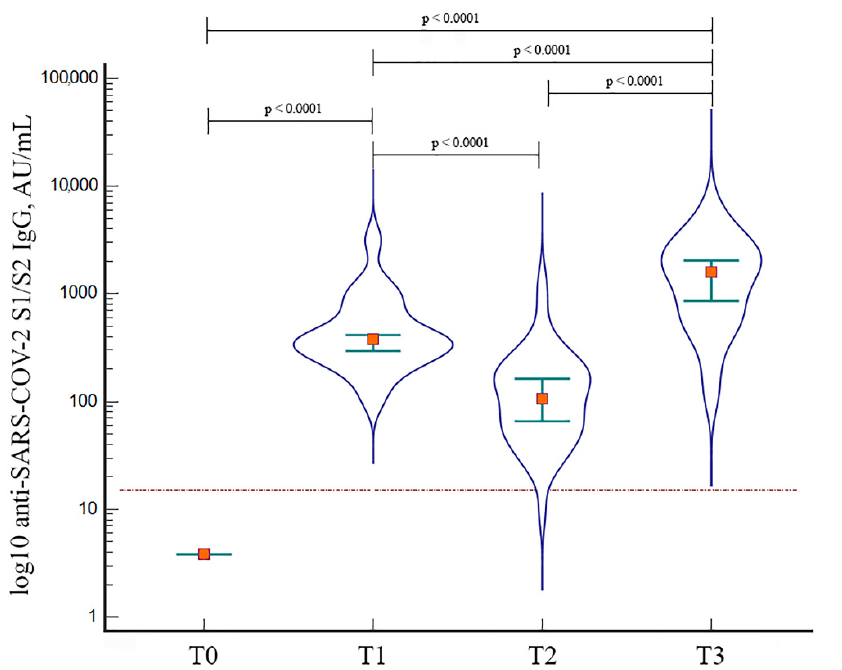
Figure 1. Violin plot showing the median concentration (orange box) of anti-SARS-CoV-2 S1/S2 IgG at the four time points: T0 (pre-vaccination), T1 (4 weeks after the second dose), T2 (pre-booster) and T3 (4 weeks after the booster dose). Green bars show the IQR (25–75 percentiles). The red line indicates the cut-off for reactivity (15 AU/mL).